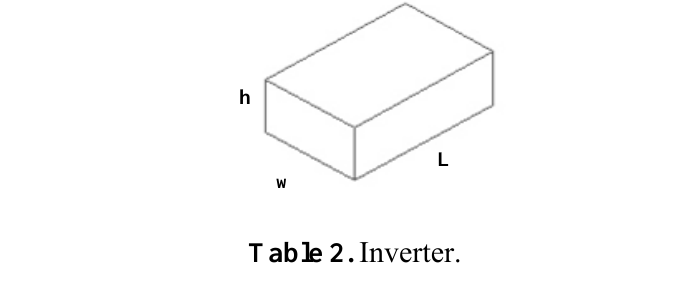
Figure 3. Inverter; L = 410 mm, w = 340 mm, h = 138 mm.